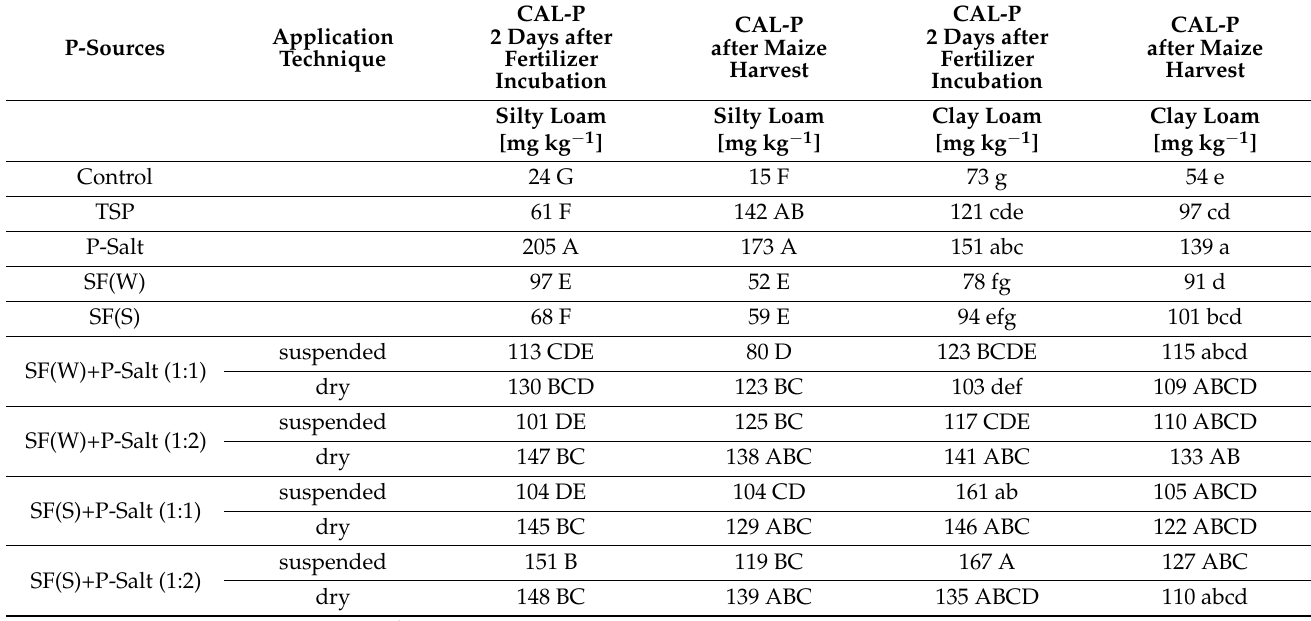
Table 3. CAL-extractable P (CAL-P) in